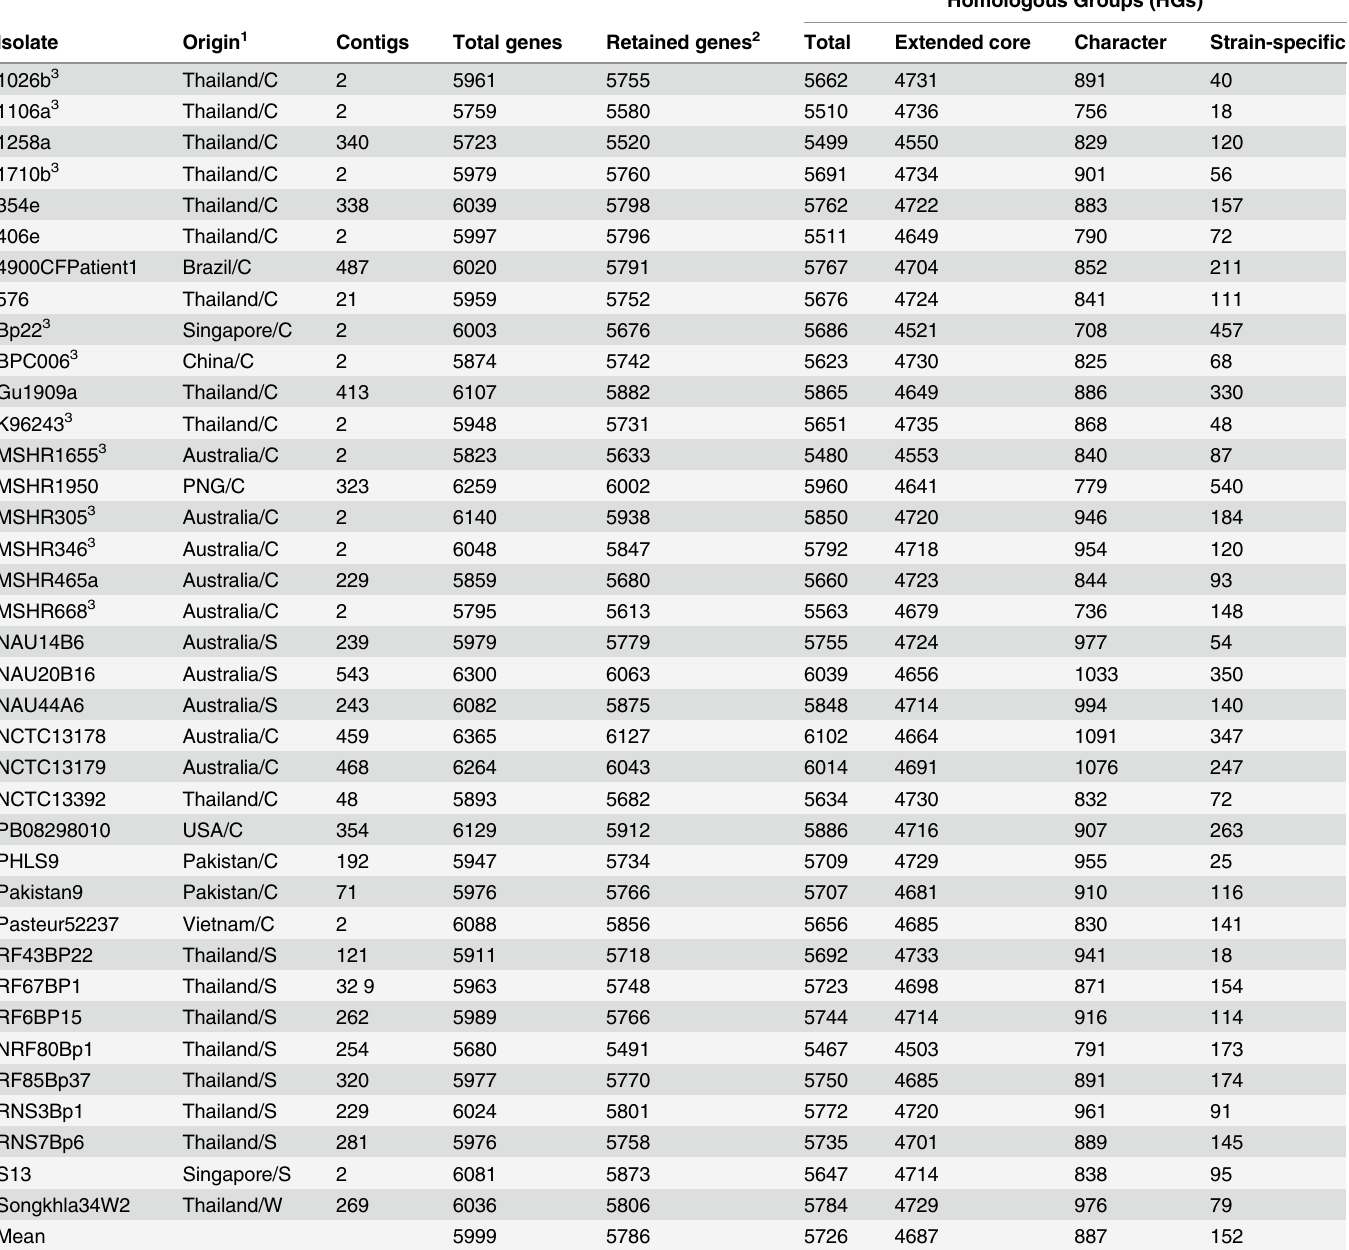
Table 1. Number of genes identified by